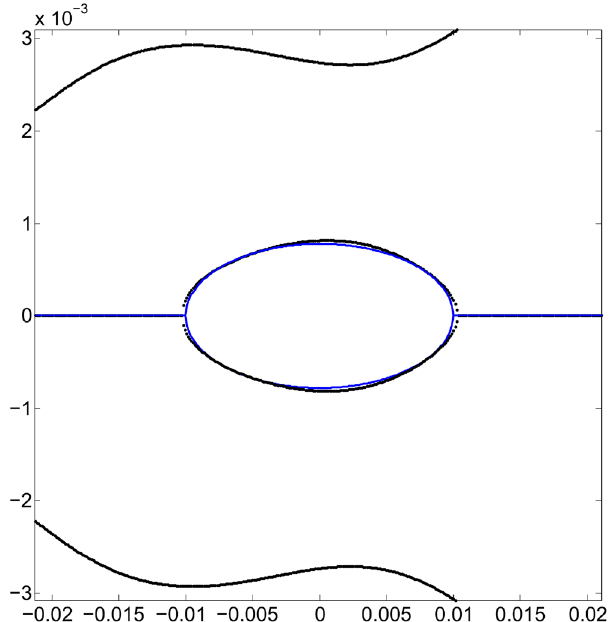
Figure 8. Structure of the phase space ( x , p x ) at the end of the third optimization process stage of the sextupoles set. The black curves are obtained as the branches of real roots solutions that give a minimum value of f obj . Starting from the sextupoles { S 1 } , that had optimized the objective function f obj with amplitude x 0 = 7 mm, a new set of sextupoles { S 2 } is found when x 0 = 10 mm is used. With the new sextupoles { S 2 } (Eq. (27)), no low order resonances are present since the real solution branches have been separated by the optimization process when requested that the inner branches are close to the Courant-Snyder ellipse, in blue. The dynamic aperture is now beyond 10 mm. Units in the plot are